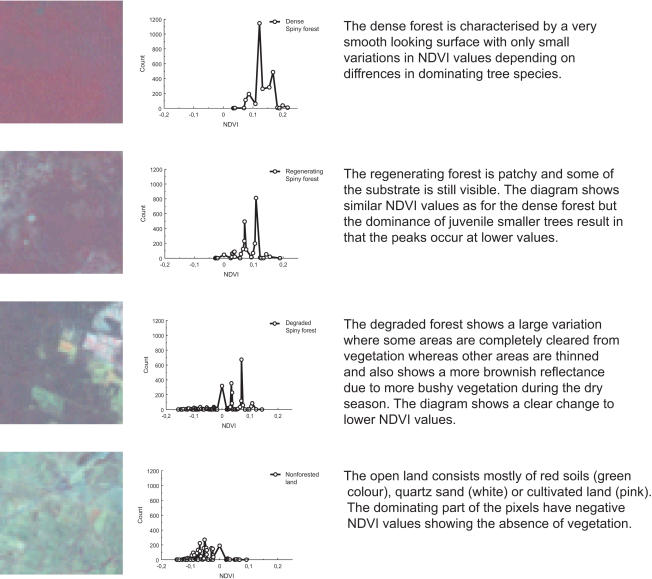
In the NDVI analysis (Normalised Difference Vegetative Index), the dense mature forests show multiple peaks due to differences in species composition, the regenerating forest is separated with lower NDVI values, while degraded forest and open land has distinctly different patterns. The examples given here are subsets (1.5×1.5 km) from the 2000 Landsat 7ETM+image.